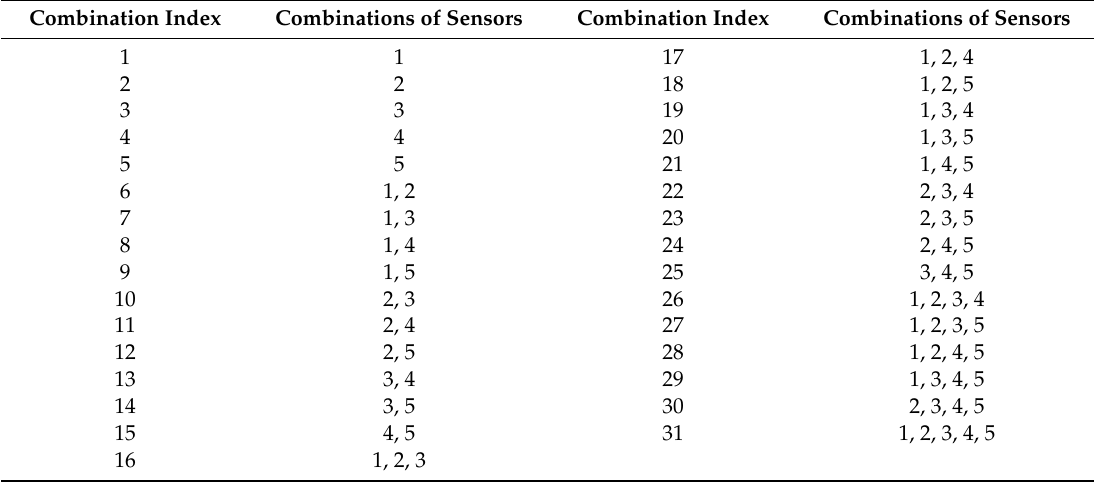
Table 3. Relationships between combination indices and combinations of